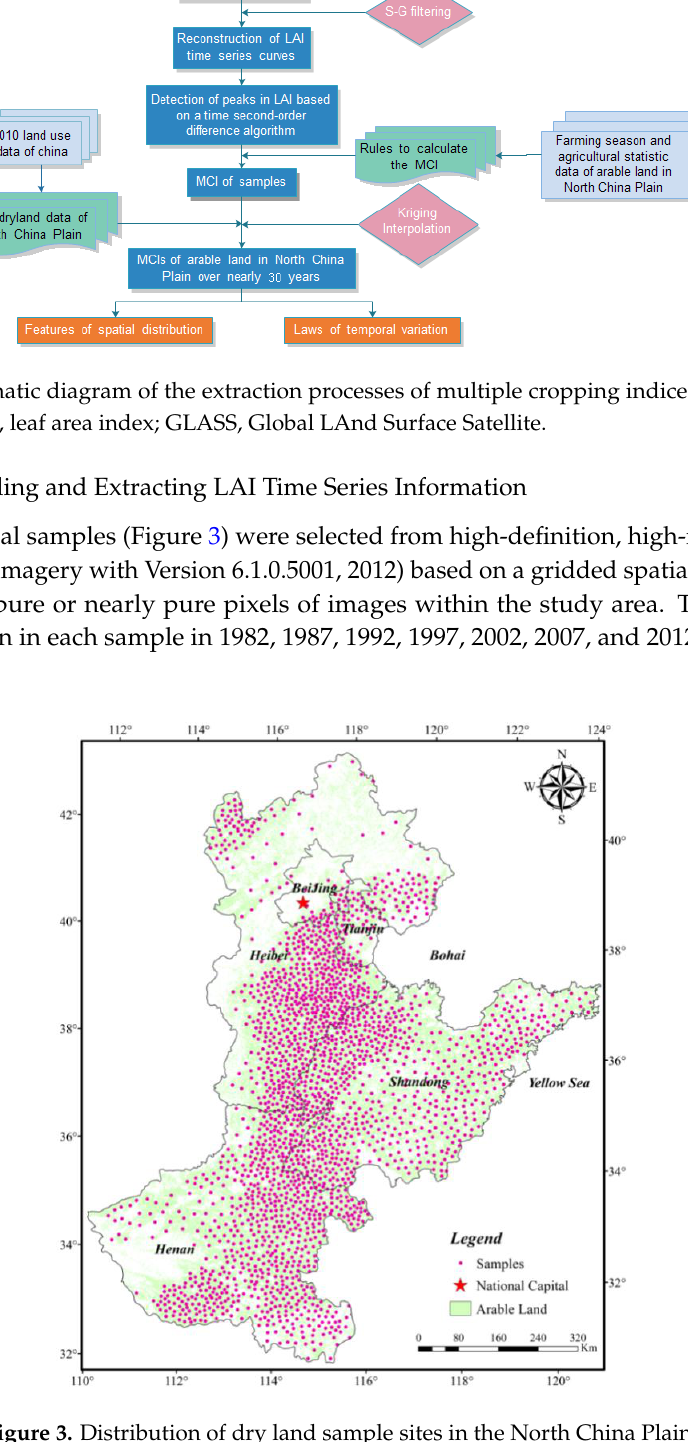
Figure 3. Distribution of dry land sample sites in the North China Plain.